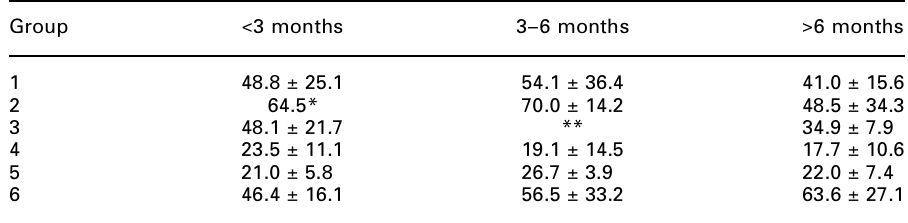
Table 3. Results of blood histamine determinations (ng/ml: mean±SEM) according to the age of infants and children